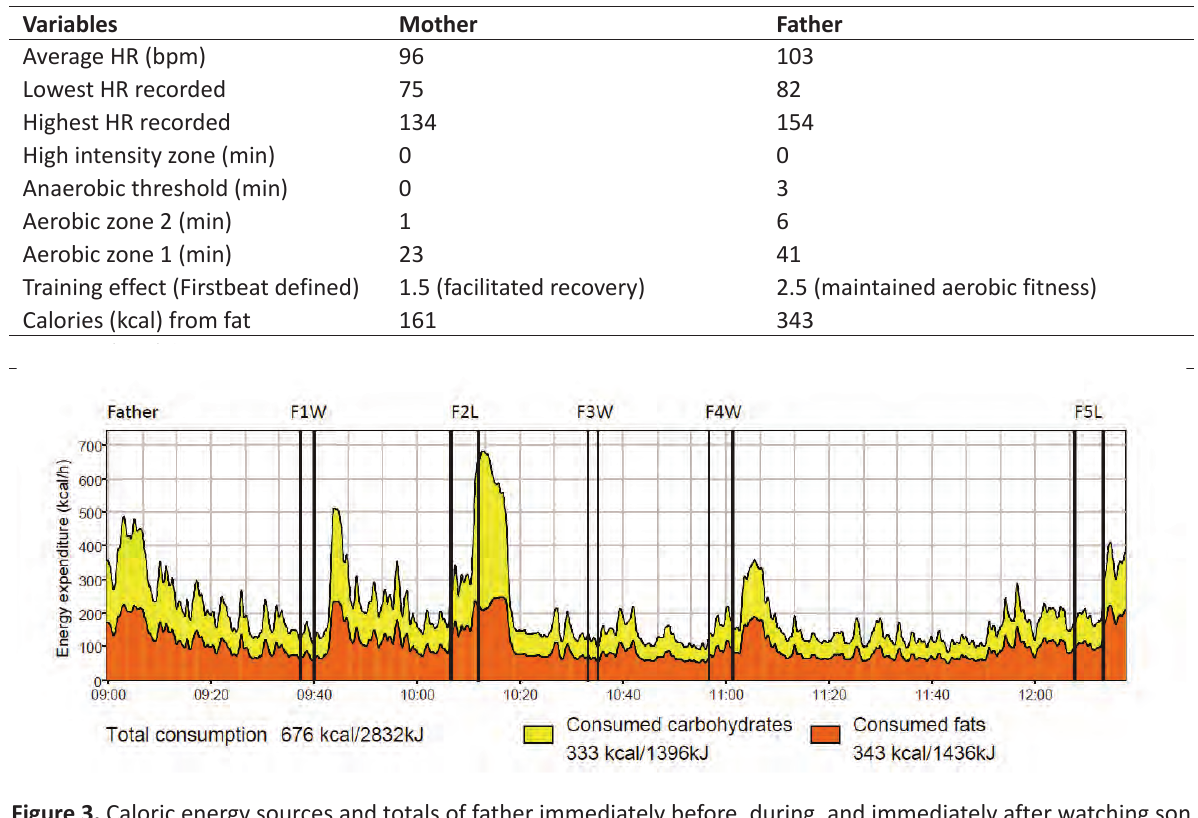
Figure 3. Caloric energy sources and totals of father immediately before, during, and immediately after watching son compete